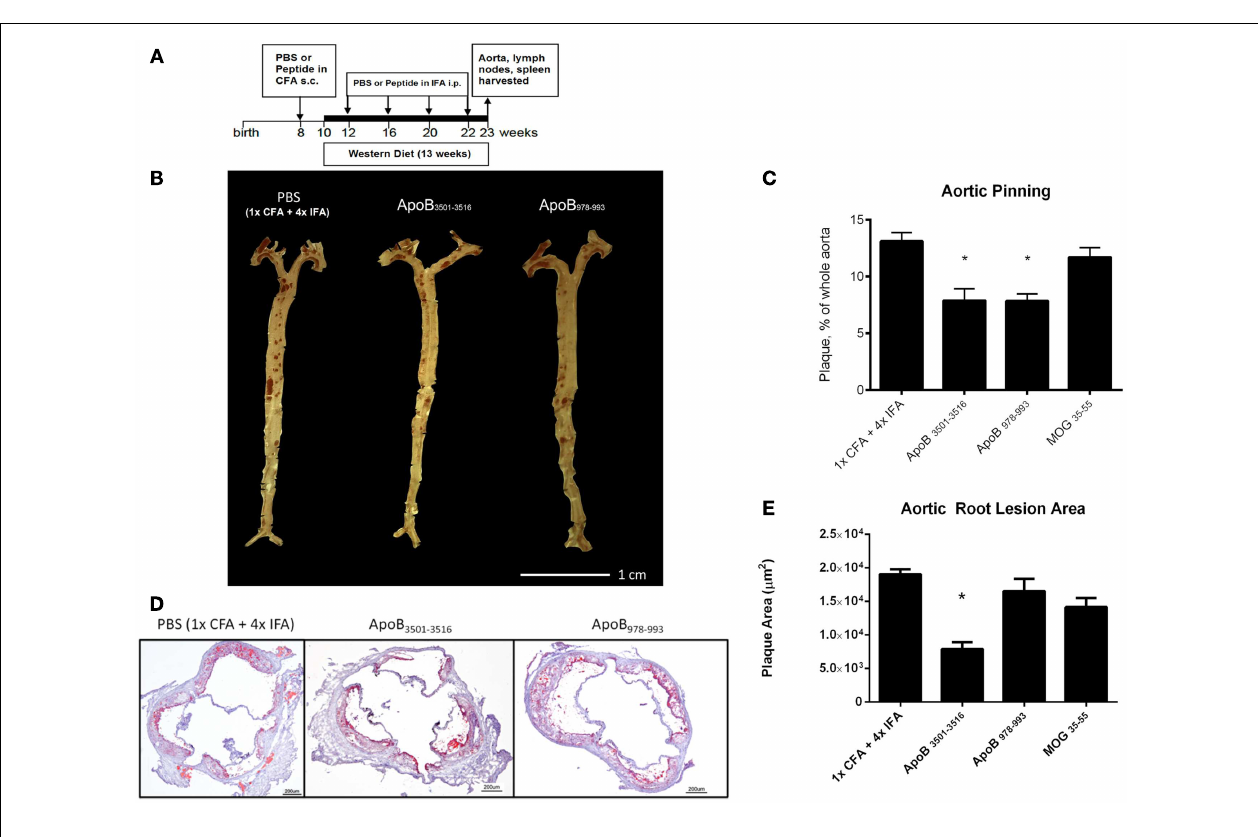
representative photographs. N = 12–15 in each group, * p < 0.05 when compared to 1 × CFA + 4 × IFA group. (D) Representative aortic root staining sections after ORO staining, counter-stained with hematoxylin. (E) Plaque area from aortic roots stained from each group. Lesion sizes from 30 to 40 µ m distal to start of the aortic valve were averaged per group. N = 5 in each group, * p < 0.05 when compared to 1 × CFA + 1 × IFA control group.